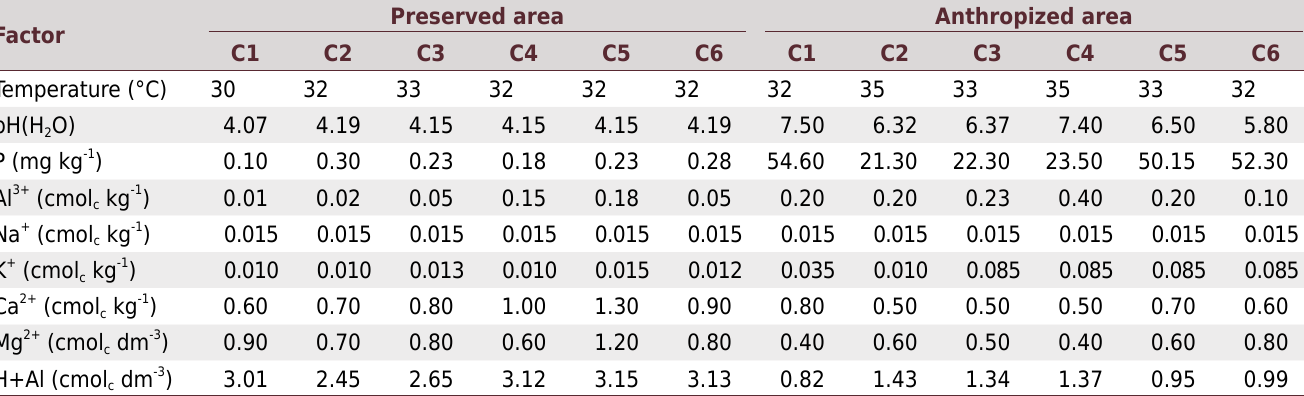
H+Al (cmol c dm -3